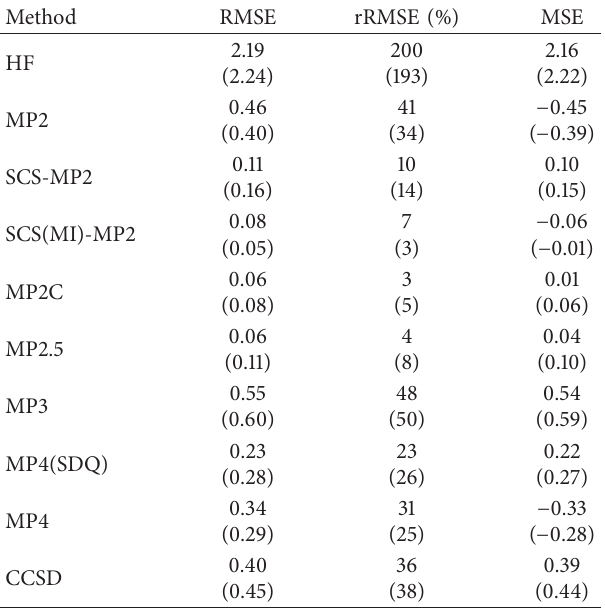
Table 3: Errors (RMSE, rRMSE (%), and MSE; in kcal/mol or %) in 𝐸 int obtained from various wave function theory methods within the supermolecularapproach.Theerrorswithoutparentheseshavebeen calculated relative to the CCSD(T)/def2-QZVPP+mb results, while those put in parentheses are based on the CCSD(T)/CBS reference values of 𝐸 int